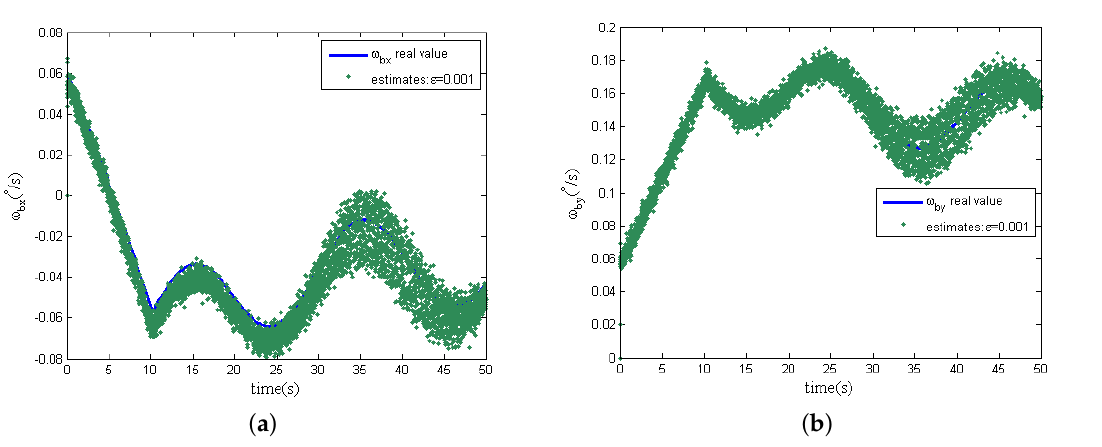
Figure 8. Estimation of spacecraft angular rates with measurement noise ( ε = 0.001). ( a ) x-axis angular rate ω bx ; ( b ) y-axis angular rate ω by